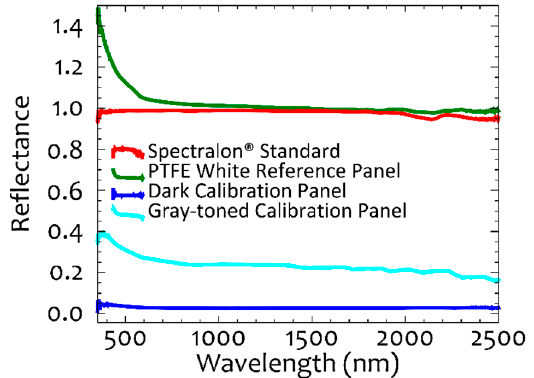
Figure 6. Laboratory reflectance spectroscopy results of white reference panel and custom-made calibration panels with respect to Labsphere Spectralon ® standard. The reflectance properties of the PTFE white reference panel are very similar to those of the Labsphere Spectralon ® except the shorter wavelengths of the visible portion of the EMS.